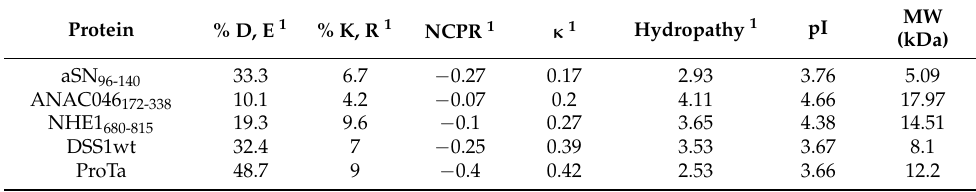
Table 1. Properties of calcium-binding